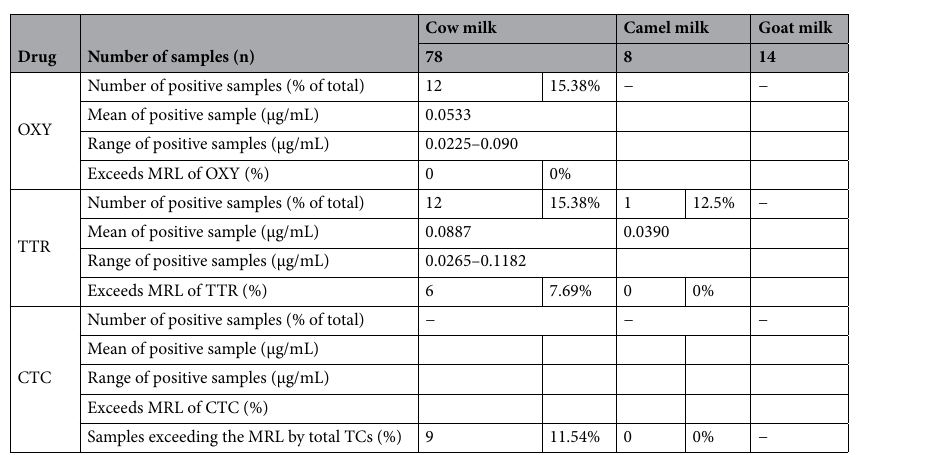
Table 6. Presence of TCs residues in milk products (sample size n = 100).